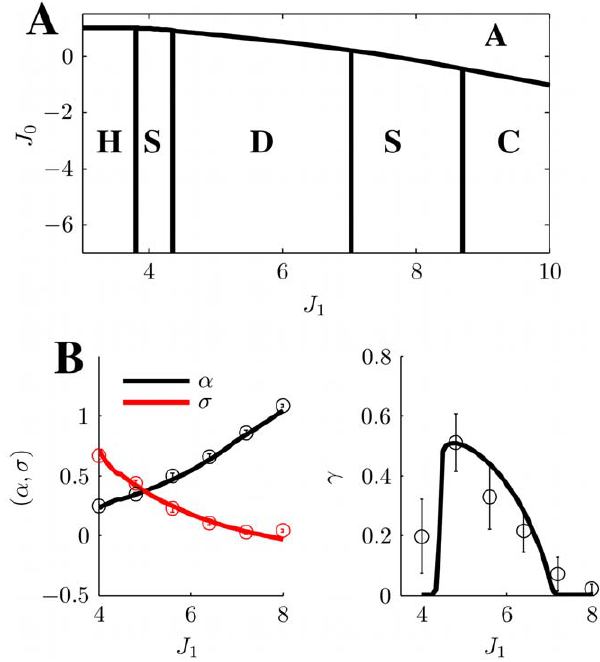
Figure 9. Comparison between MF solutions and microscopic network dynamics. A: Phase diagram from MF analysis for m ~ 0 : 95 . B: Order parameters from the numerical solution of MF equations (solid curves) with varying J 1 ; estimated order parameters from simulation results; dots with error bars, average and s.d. over 6 simulations with different realizations of the neural maps. N ~ 5000 neurons. J 0 ~{ 5 .